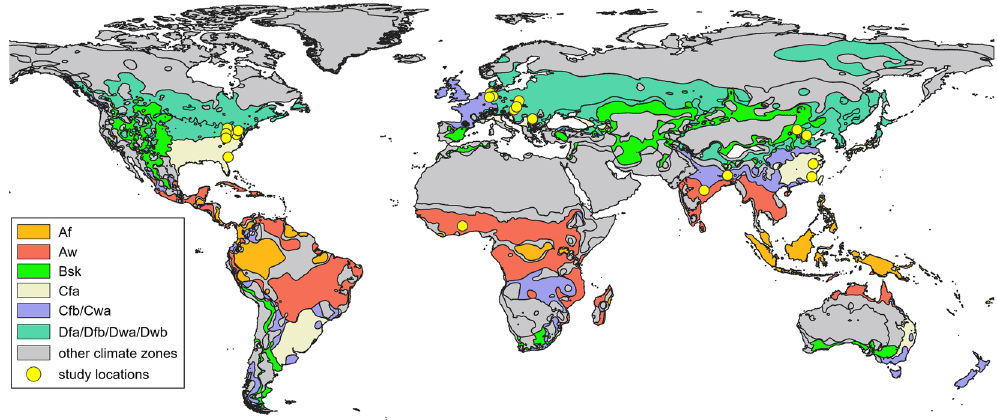
Figure 1. Global distribution of climate zones and study sites represented in this meta-analysis. The climate is classified according to Koeppen–Geiger (Af = tropical rainforest/equatorial climate; Aw = tropical savanna or tropical wet and dry climate; Bsk = semi-arid/semi-desert/steppe climate; Cfa = humid subtropical climate; Cfb/ Cwa = oceanic/maritime/marine climate; Dfa/Dfb/Dwa/Dwb = humid continental climate). This map is based on climate zone data sourced from Peel et al. 53